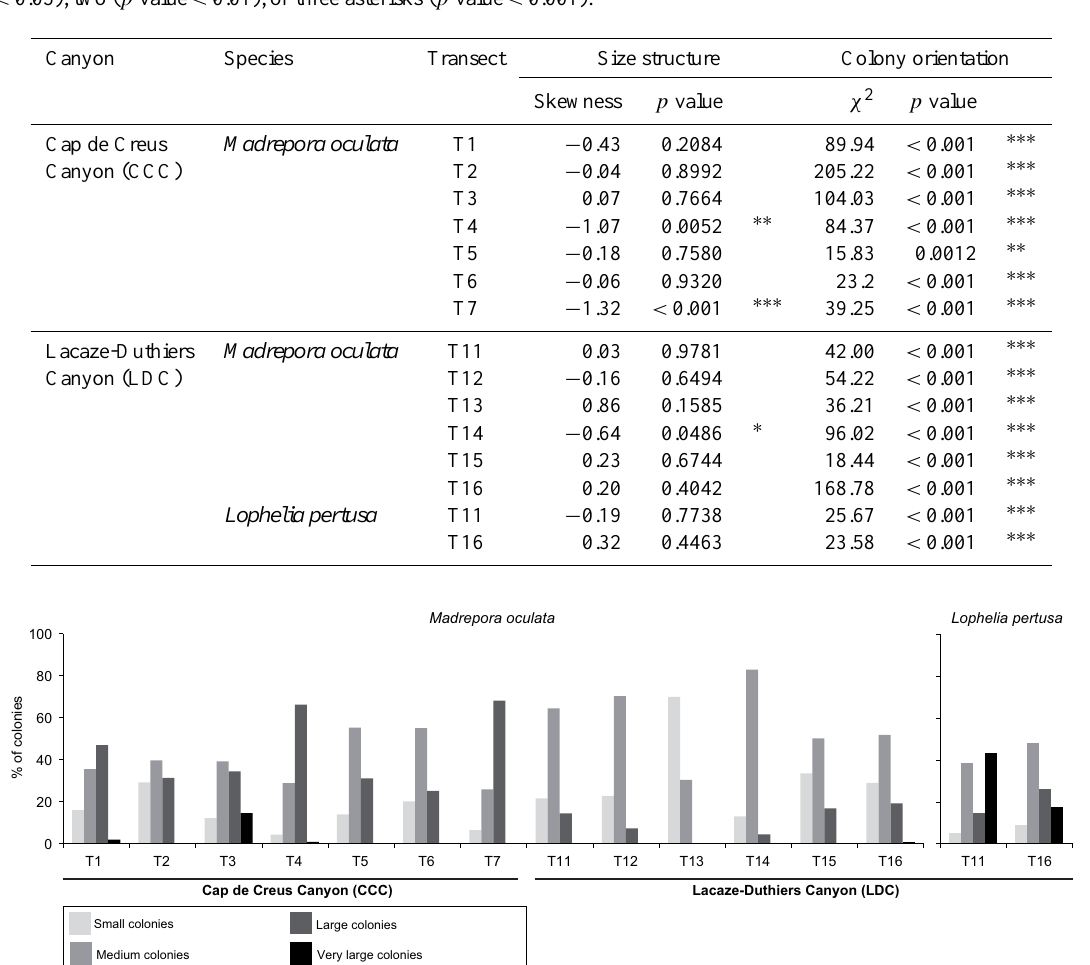
Table 3. Skewness of the size structures, and chi-square test on colony orientation in the studied populations of Madrepora oculata and Lophelia pertusa in the Cap de Creus Canyon (CCC) and Lacaze-Duthiers Canyon (LDC); significant p values are indicated with one ( p value < 0.05), two ( p value < 0.01), or three asterisks ( p value < 0.001).